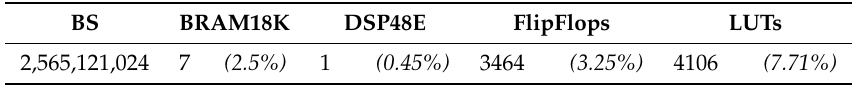
Table 5. Post-Synthesis results for the HyperLCA Coder block for a Xilinx Zynq-7020 programmable SoC and pixel size up to 180